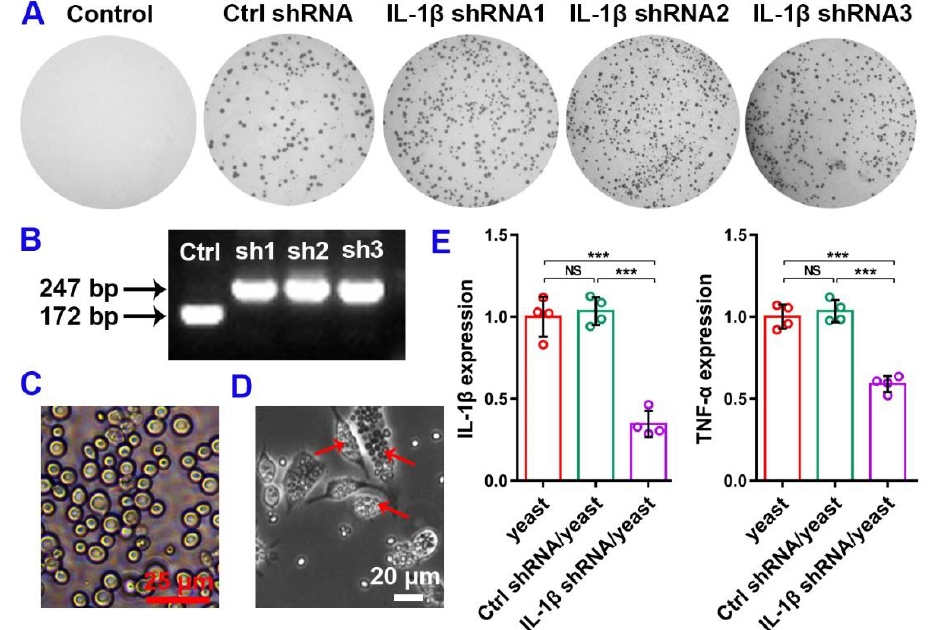
Figure 1. Construction and functional verification of shRNA/yeast. ( A ) Construction of shRNA/yeast by chemical transformation of shRNA plasmid. Only the shRNA/yeast containing shRNA +uracil can survive in uracil deficient medium. ( B ) PCR detection of single yeast clone (Ctrl, sh1, sh2, sh3 refer to control shRNA/yeast, IL- 1β shRNA1/yeast, IL- 1β shRNA2/yeast and IL- 1β shRNA3/yeast). ( C ) Morphology of shRNA/yeast in bright field. ( D ) shRNA/yeast was engulfed by macrophage. ( E ) IL- 1β and TNF- α expression in macrophages after treatment with IL- 1β shRNA/yeast. NS (no significance). *** p < 0.001 ( n = 4).